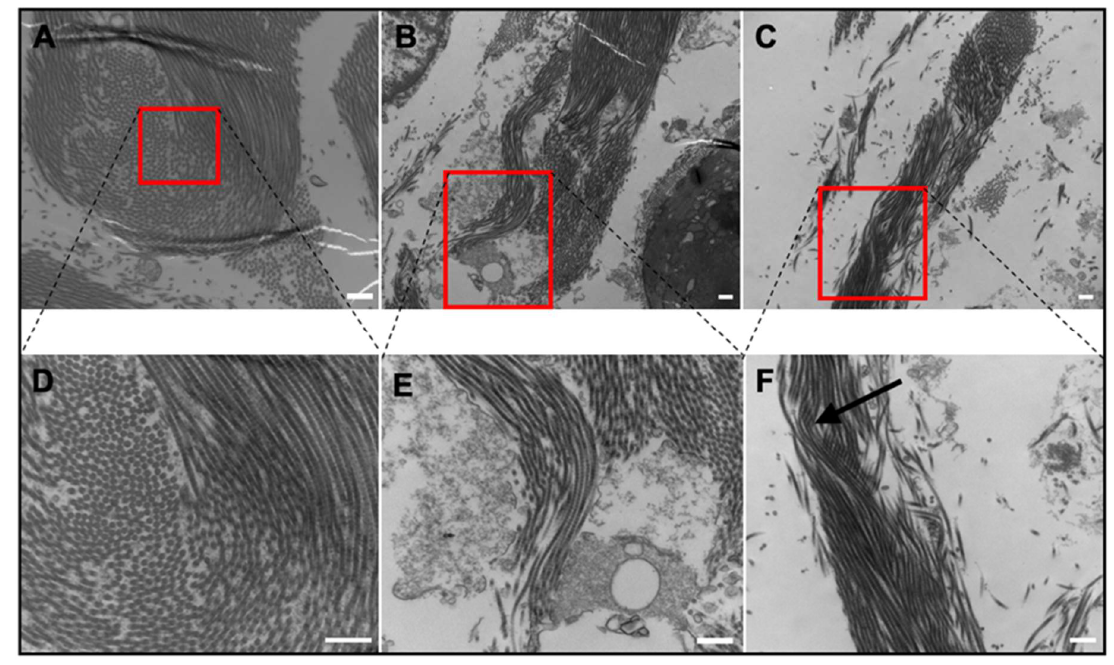
Figure 6. TEM images of the rat bladder. ( a ) Alternating collagen orientation. 17,500×. Scale bar 500 nm. ( b ) Crimp structure. 13,500×. Scale bar 500 nm. ( c ) Helical structure. 9700×. Scale bar 500 nm. ( d ) Magnified alternating collagen orientation. 33,000×. Scale bar 500 nm. ( e ) Magnified crimp structure. 24,500×. Scale bar 500 nm. ( f ) Magnified helical structure. 17,500×. Scale bar 500 nm.